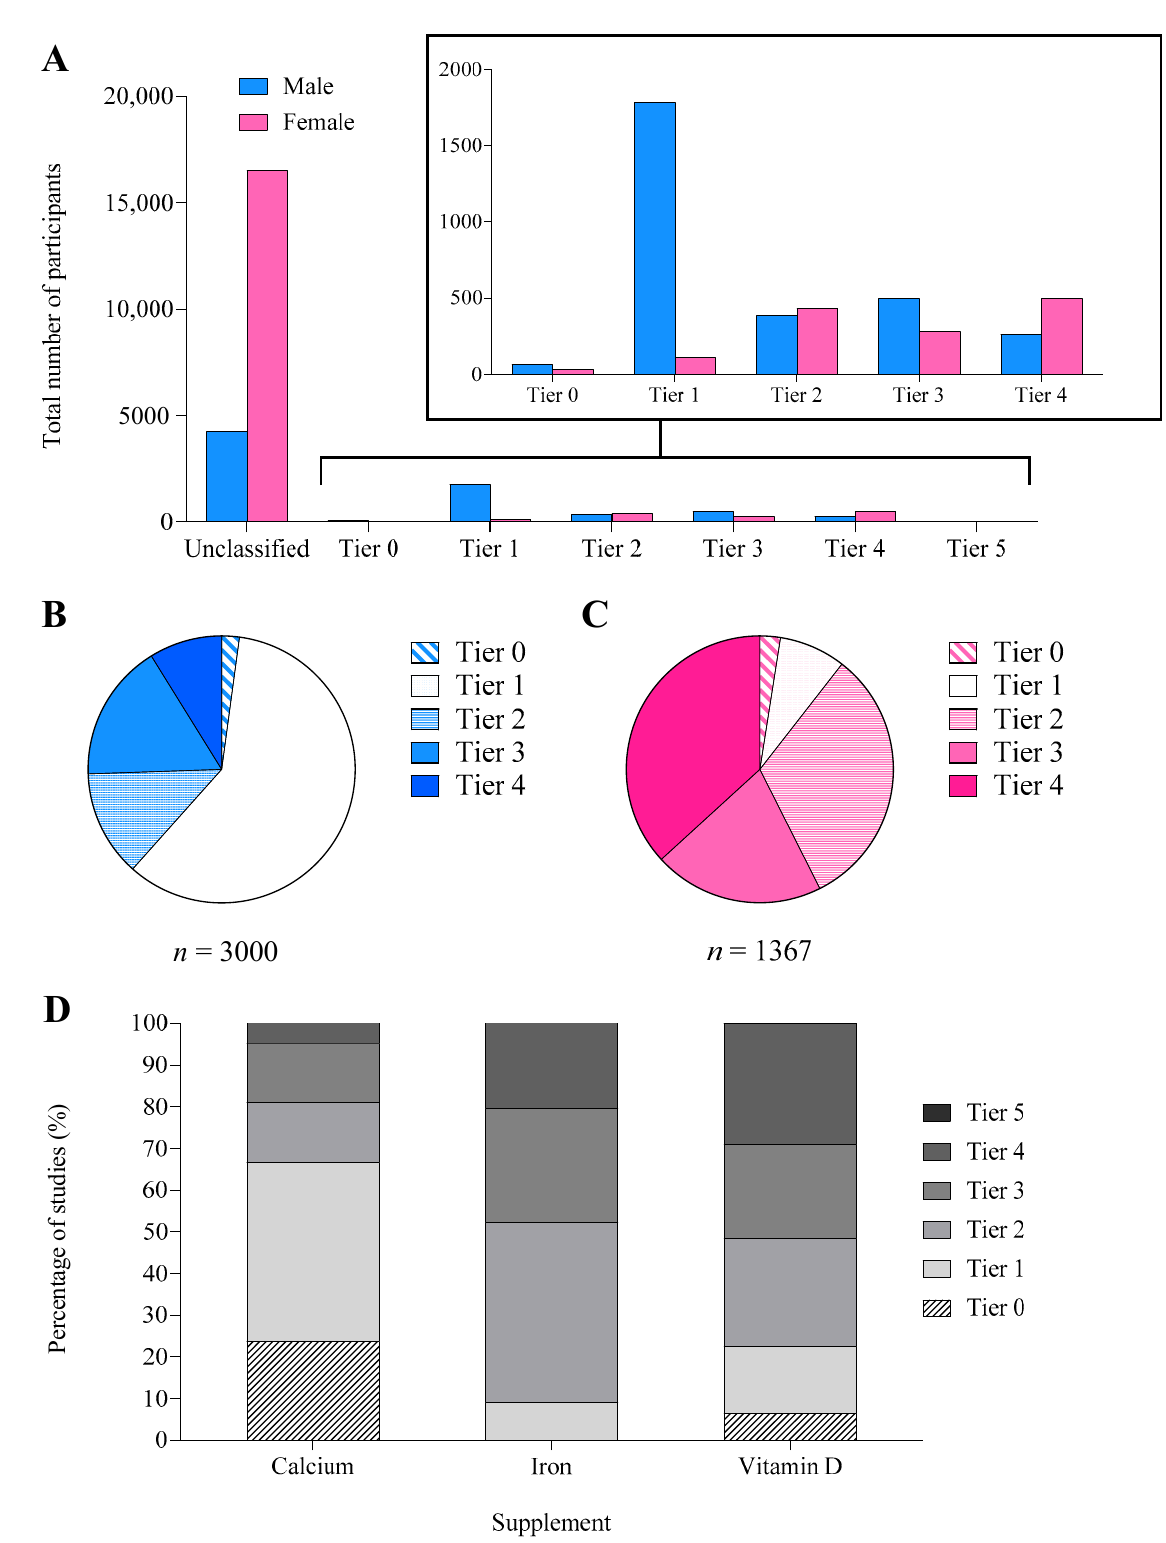
Figure 4. ( A ) Total number of male and female participants and the proportion of male ( B ) and female ( C ) participants in each athletic tier [19]: Tier 0 (sedentary), Tier 1 (recreationally active), Tier 2 (trained/developmental), Tier 3 (highly trained/national), Tier 4 (elite/international), and Tier 5 (world-class). ( D ) The proportion of participants in each athletic tier separated by supplement. Only classifiable participants are reported in all figures.